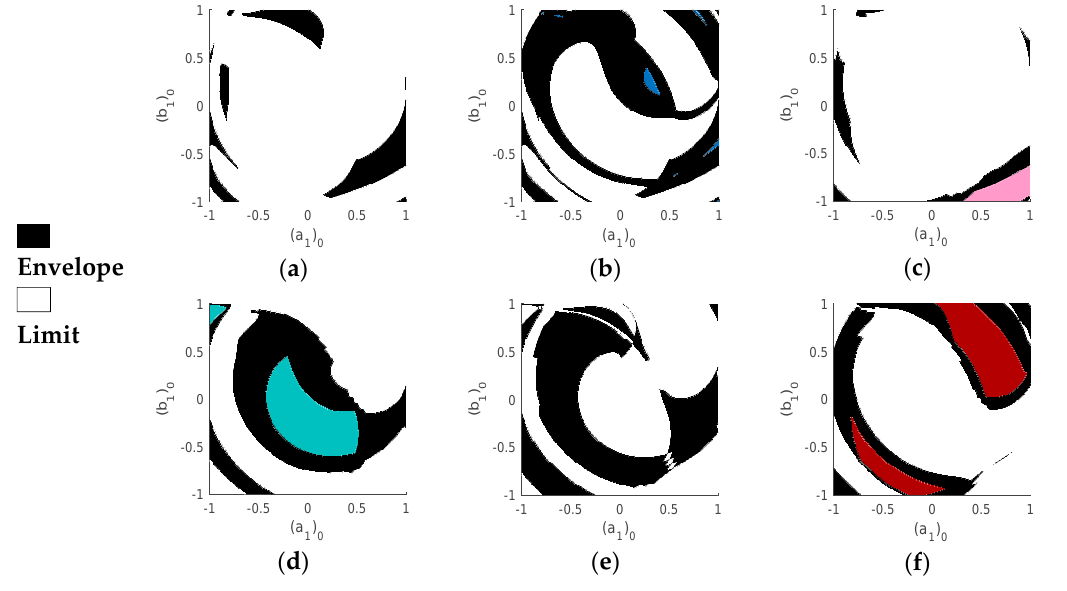
Figure 17. Envelopes of the attractors of ( a ) DM-RB, ( b ) DM-NRB, ( c ) DM-B1, ( d ) DM-B2, ( e ) TM-B1 and ( f ) TM-B2 of the amplitude (cid:3627)(cid:1827)(cid:4634) (cid:2869) (cid:3627) (((cid:1853) ) ((cid:1854) ) ) for (cid:2026) = −1 , ((cid:1853) (cid:2869) (cid:2868) , (cid:2869) (cid:2868) method for (cid:2012) (cid:3039) = 2% .